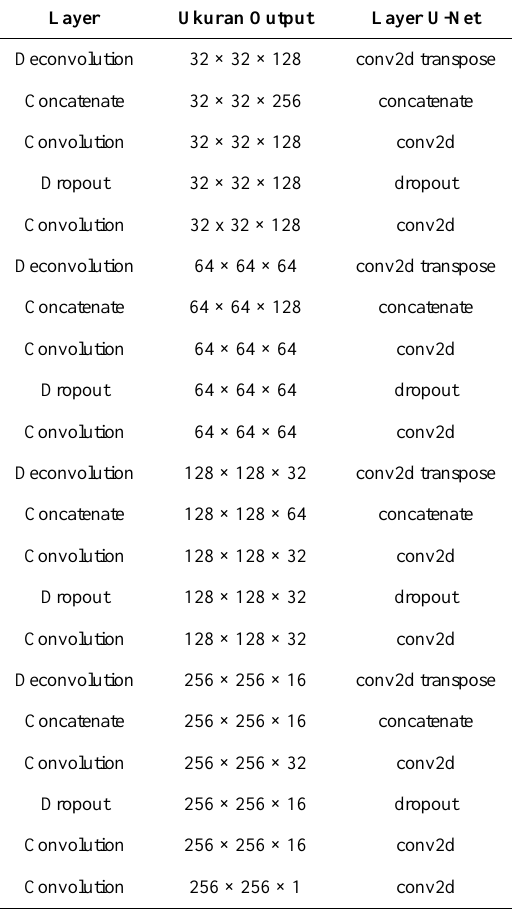
Table 2. U-Net decoder